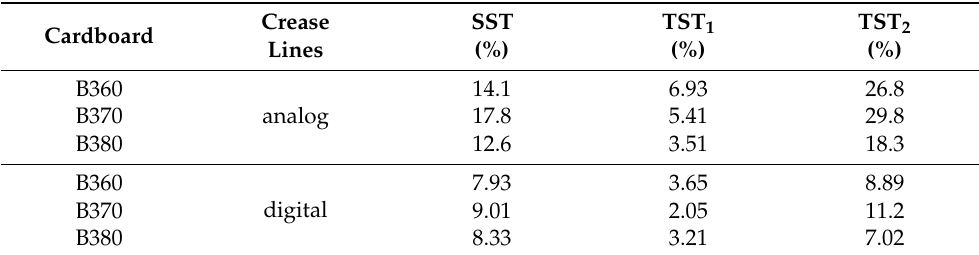
Table 4. Percentage differences between results for crease-free region samples and samples perpen- dicular to the